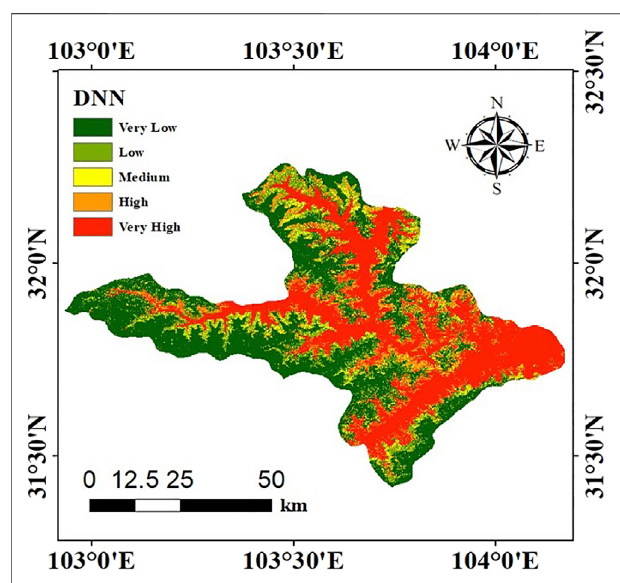
FIGURE 5 | Geological disaster susceptibility